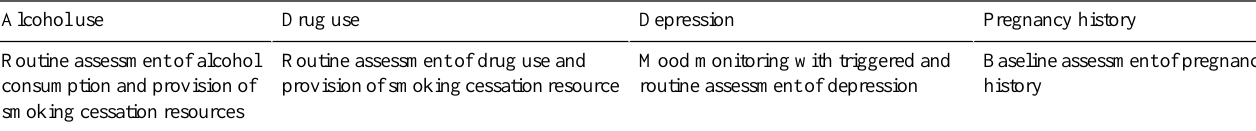
Table 2. Pregnancy risk factors noted in literature, but not in these interviews.